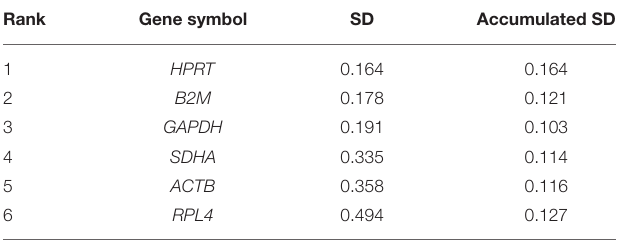
TABLE 4 | Candidate reference genes ranking according to